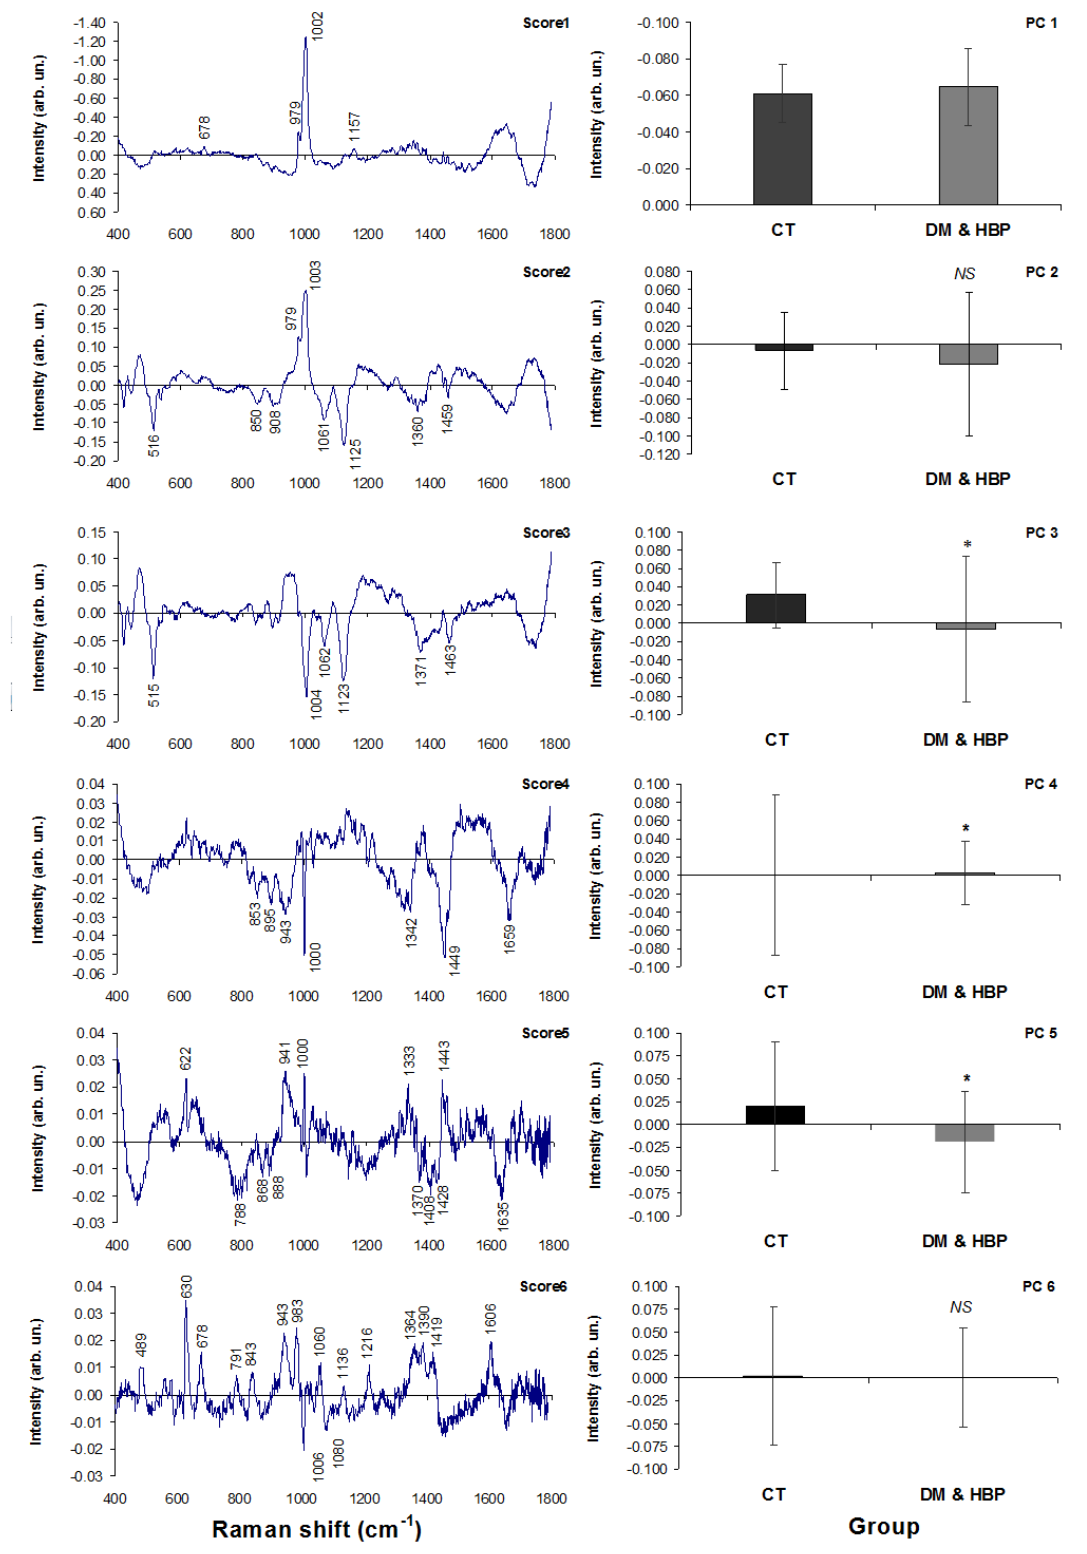
Figure 3. Plot of the first six principal component variables (Scores and PCs) extracted from the Raman dataset. The biochemical assignments seen in the Scores were based on the positions of the Raman bands compared to the literature. PC3, PC4, and PC5 show statistically significant differences between the groups ( t -test, p < 0.05